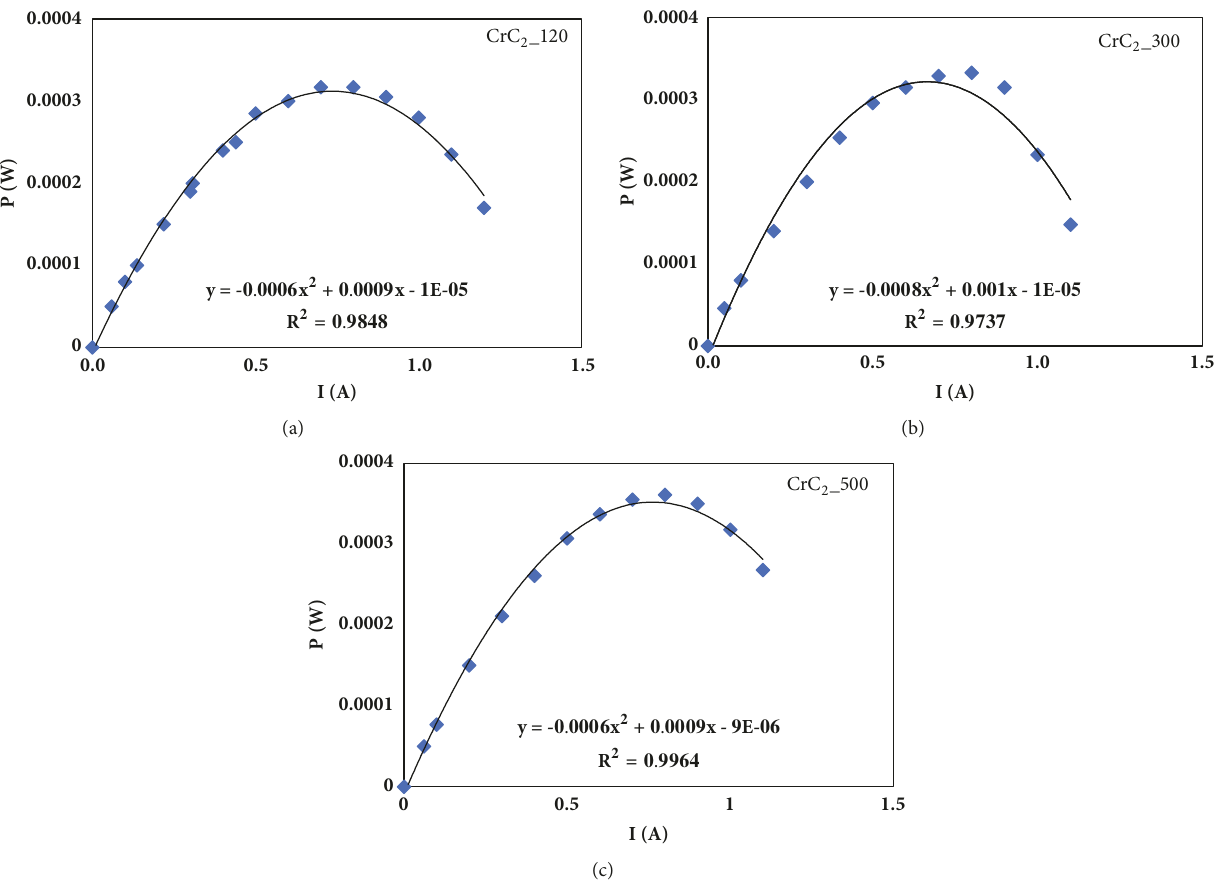
Figure 6: Graphical representation of power as a function of current intensity of different carbide-based amorphous metallic coating: (a) CrC 2 120, (b) CrC 2 300, and (c) CrC 2 500.